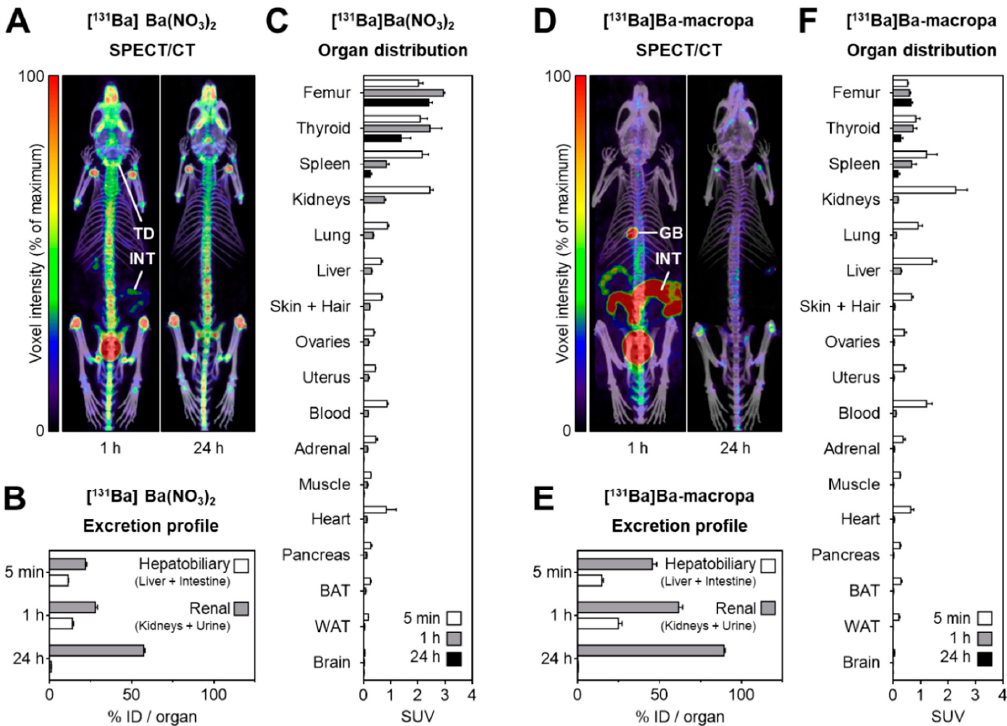
Figure 8. Distribution of [ 131 Ba]Ba(NO 3 ) 2 and [ 131 Ba]Ba-macropa in mice. Small animal SPECT images were recorded using the 124 keV photopeak window, post-processed for removal of peripheral artifacts, fused with computed tomography (CT) images, and displayed as maximum intensity projections; scaling of voxel intensities was matched with 1-h image; ( A ) SPECT/CT fusion images of [ 131 Ba]Ba(NO 3 ) 2 in a mouse 1 h and 24 h after injection; ( B , C ) excretion profile and organ distribution of [ 131 Ba]Ba(NO 3 ) 2 in mice 5 min, 1 h, and 24 h after injection ( n = 4); ( D ) SPECT/CT fusion images of [ 131 Ba]Ba-macropa in a mouse 1 h and 24 h after injection; ( E , F ) excretion profile and organ distribution of [ 131 Ba]Ba-macropa in mice; 5 min, 1 h, and 24 h after injection ( n = 4); (BAT) brown adipose tissue; (GB) gall bladder *; (ID) initial dose; (INT) intestine; (TD) thyroid/parathyroid *; (WAT) white adipose tissue (* activity in these organs was not measured separately). Organ distribution showed rapid clearance of 131 Ba-labeled macropa from blood and significantly ( p < 0.001) lower accumulation in bones compared to [ 131 Ba]Ba(NO 3 ) 2 , as occurred in the femur within 5 min (SUV = 0.53) and slightly increased within 24 h (SUV = 0.65) (Figure 8F). Furthermore, injection of 131 Ba-labeled macropa resulted in significantly ( p < 0.001) lower accumulation of barium-131 in the thyroid or parathyroid compared to [ 131 Ba]Ba(NO 3 ) 2 . These results